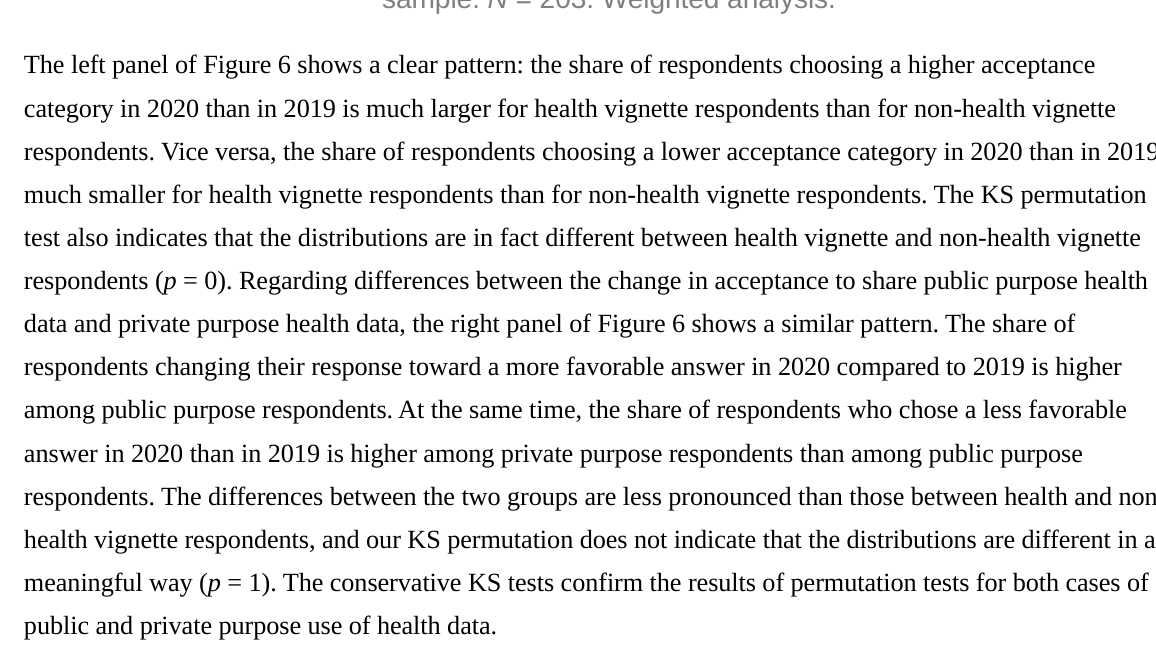
Figure 6. Changes in response category chosen by the respondents from 2019 to 2020 in the longitudinal sample. Left panel: Cross-sectional samples: N = 2,371. Longitudinal sample: N = 627. Right panel: Cross-sectional samples: N = 784. Longitudinal sample: N = 203. Weighted